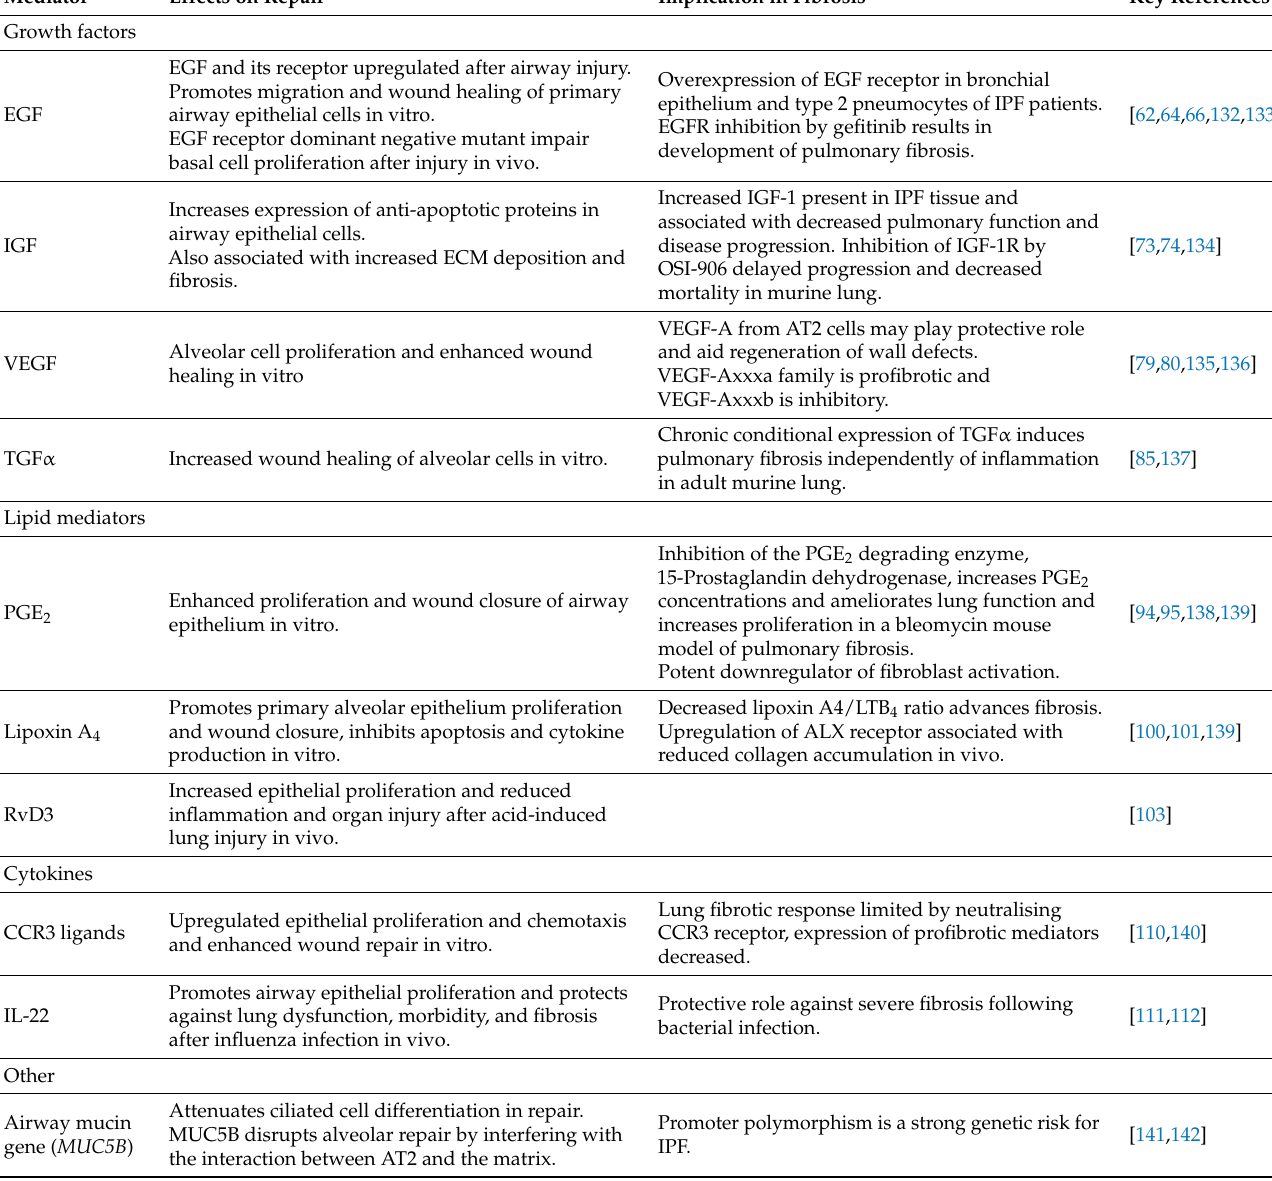
Table 1. Summary of soluble mediators implicated in epithelial repair and